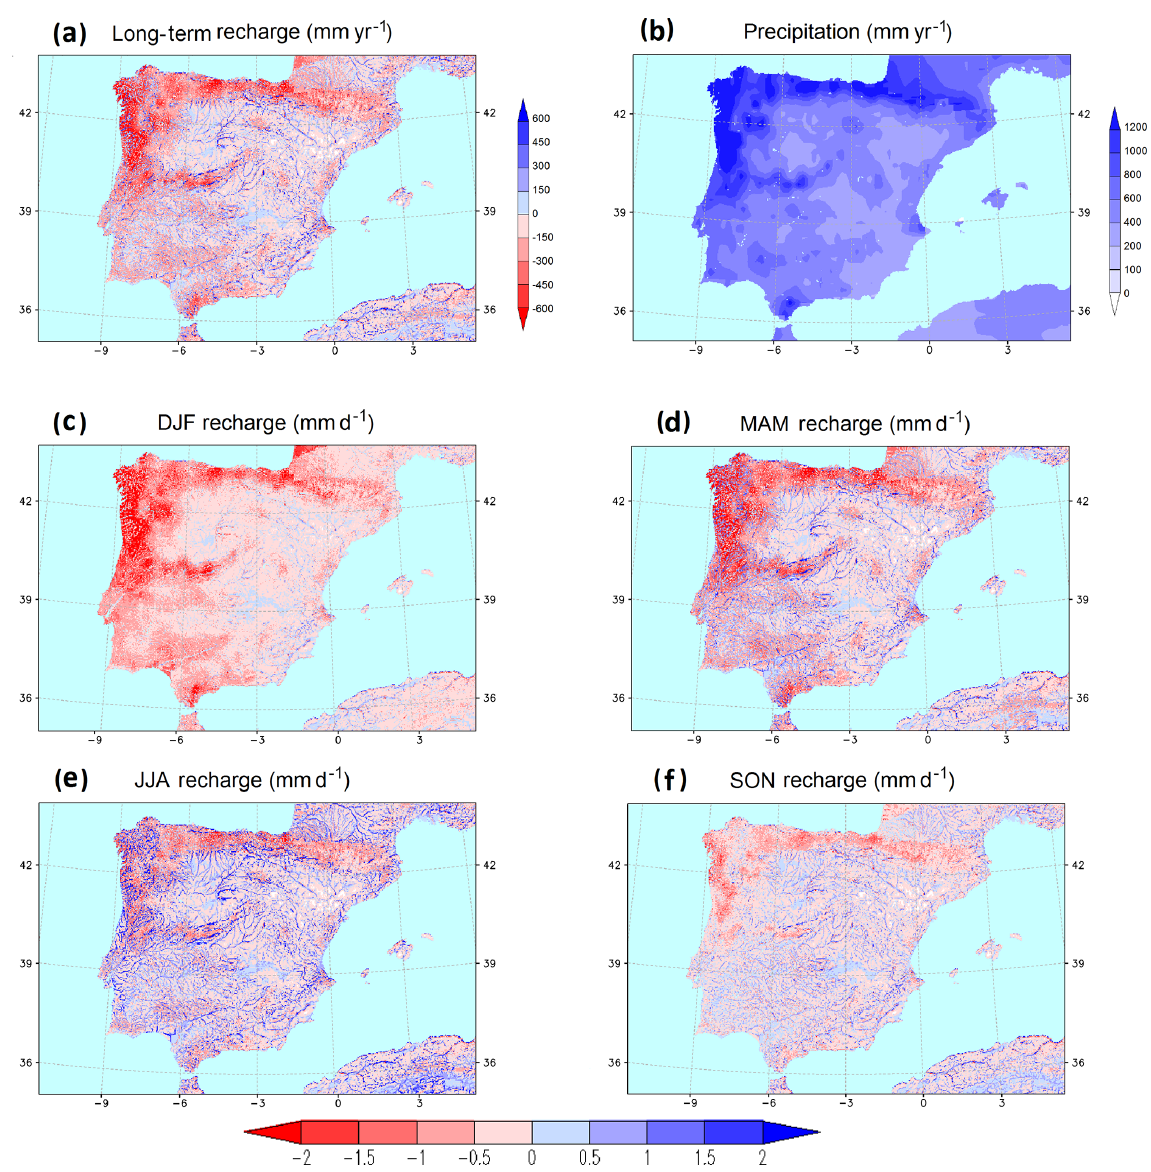
Figure 7. (a) Long-term recharge (mmyr − 1 ), defined as net moisture flux at the water table. (b) Mean precipitation (mmyr − 1 ). (c–f) Mean seasonal recharge (mmd − 1 ) for winter (DJF), spring (MAM), summer (JJA) and autumn (SON). In the recharge plots, red colours indicate negative (downward) recharge and blue colours correspond to positive (upward) flux. All values are calculated for the 10-year simulation